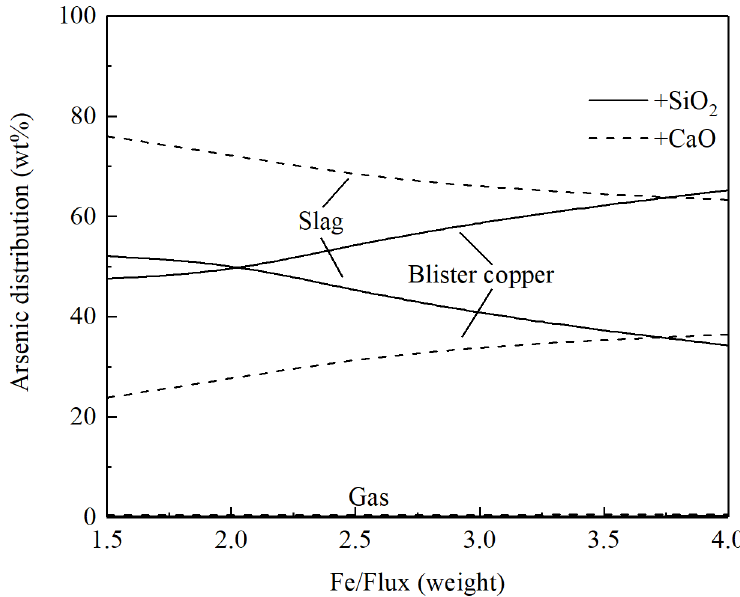
Figure 5. Effect of Fe/Flux ratio on arsenic distribution at 1290 °C and 98.5% Cu in the blister copper.